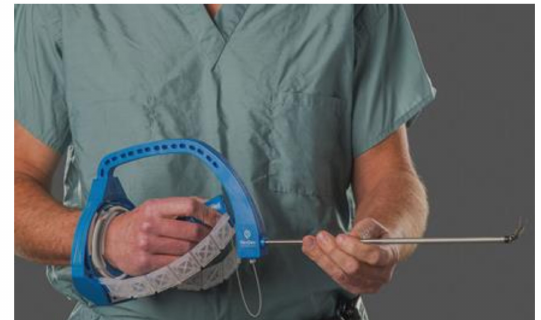
Figure 9. The FlexDex laparoscopic needle driver o ff ers wristed instrumentation similar to DaVinci robotic instruments without the costs of the robot, but still more expensive than conventional laparoscopic instruments. Image taken from https: // flexdex.com